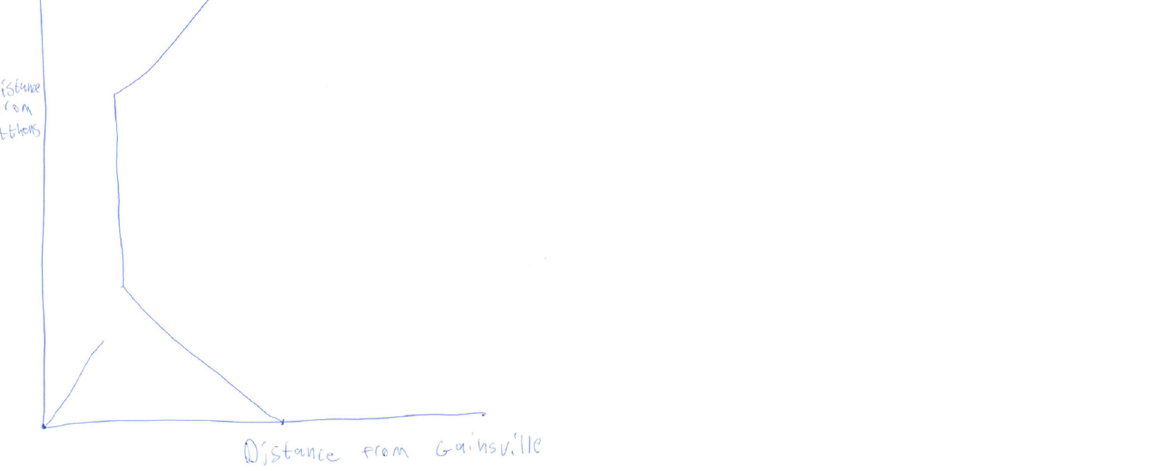
Building on a foundation of covariational reasoning, one can then shift to tasks that foster building internalized- ratio as an invariant multiplicative comparison in which the related quantities co-vary. For instance, in the same teaching experiment (Ellis, 2016), I introduced tasks in which students compared the changing area of a rectangle compared to its distance swept as its length increased. Here, students familiarized themselves with the context of sweeping out a rectangle of paint with a paint roller of unspecified height (Figure 10), and then watched videos of paint rollers sweeping out rectangles. Finally, the students were asked to think about how the area of the rectangle would change compared to the length swept.